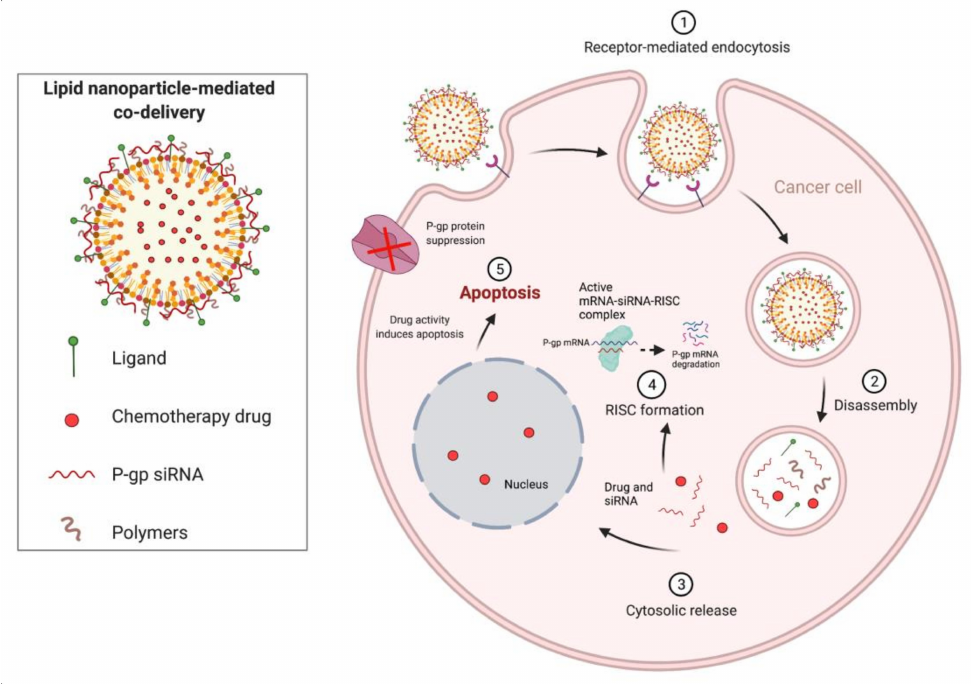
Figure 5. Combination cancer therapies in overcoming MDR.